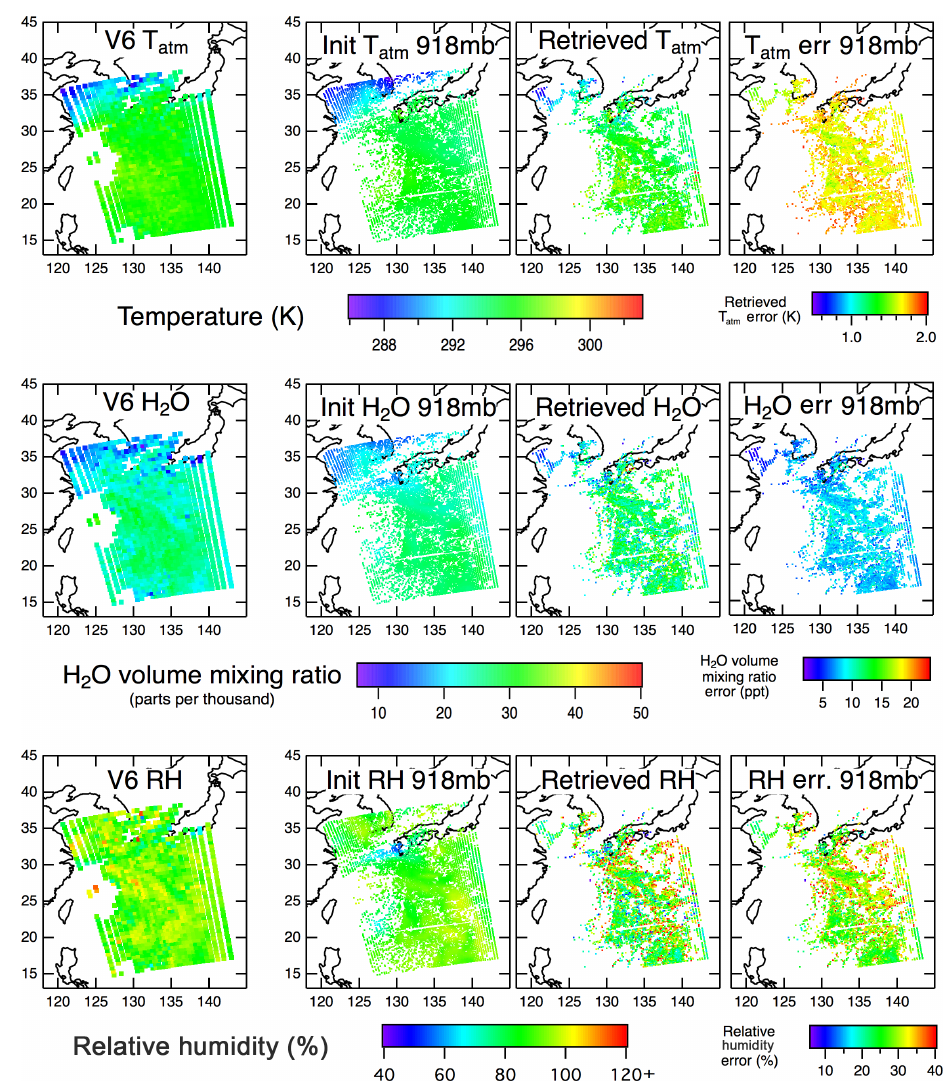
Figure 8. AIRS V6 retrieval and AIRS-OE a priori data, retrievals and errors for temperature, water vapor and relative humidity (RH) at 918mb for (daytime) Granule 44, 6 September